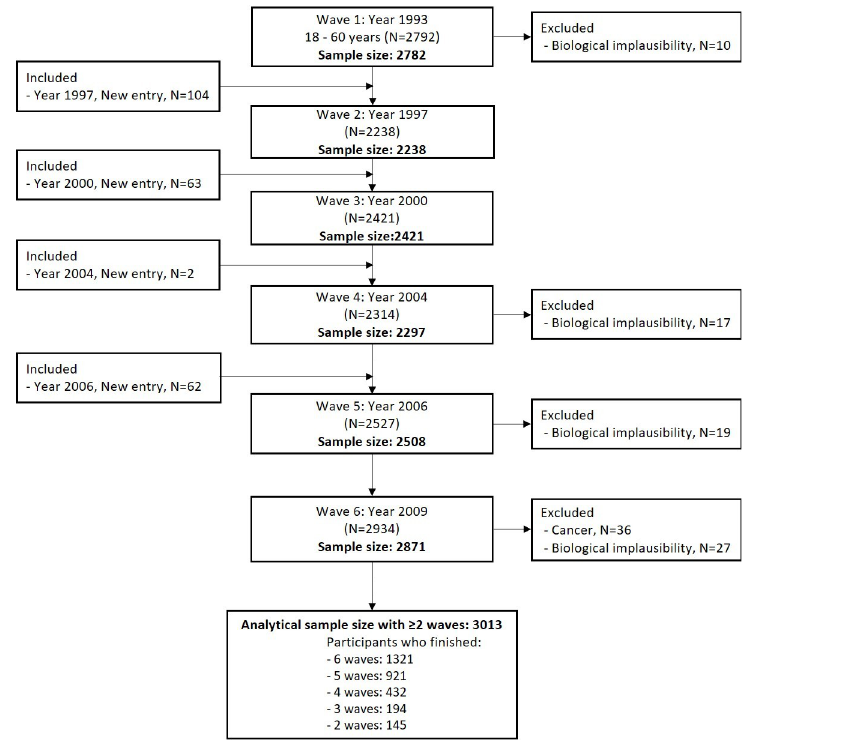
Fig 1. Flow chart of the derivation of the study